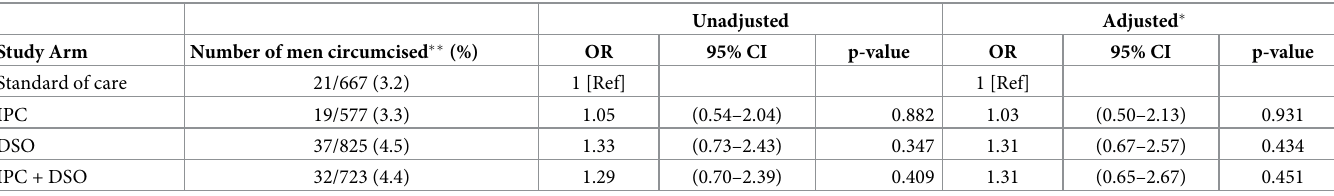
Table 2. Analysis of the effects of the interventions on uptake of VMMC three months after